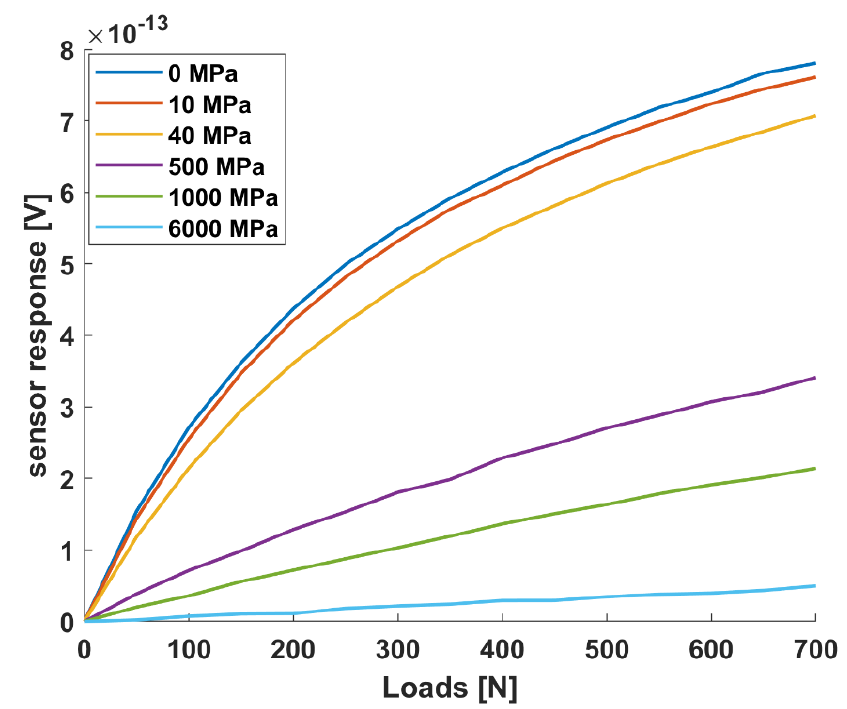
Figure 11. Simulated response of the single sensor unit varying the bone callus stiffness.